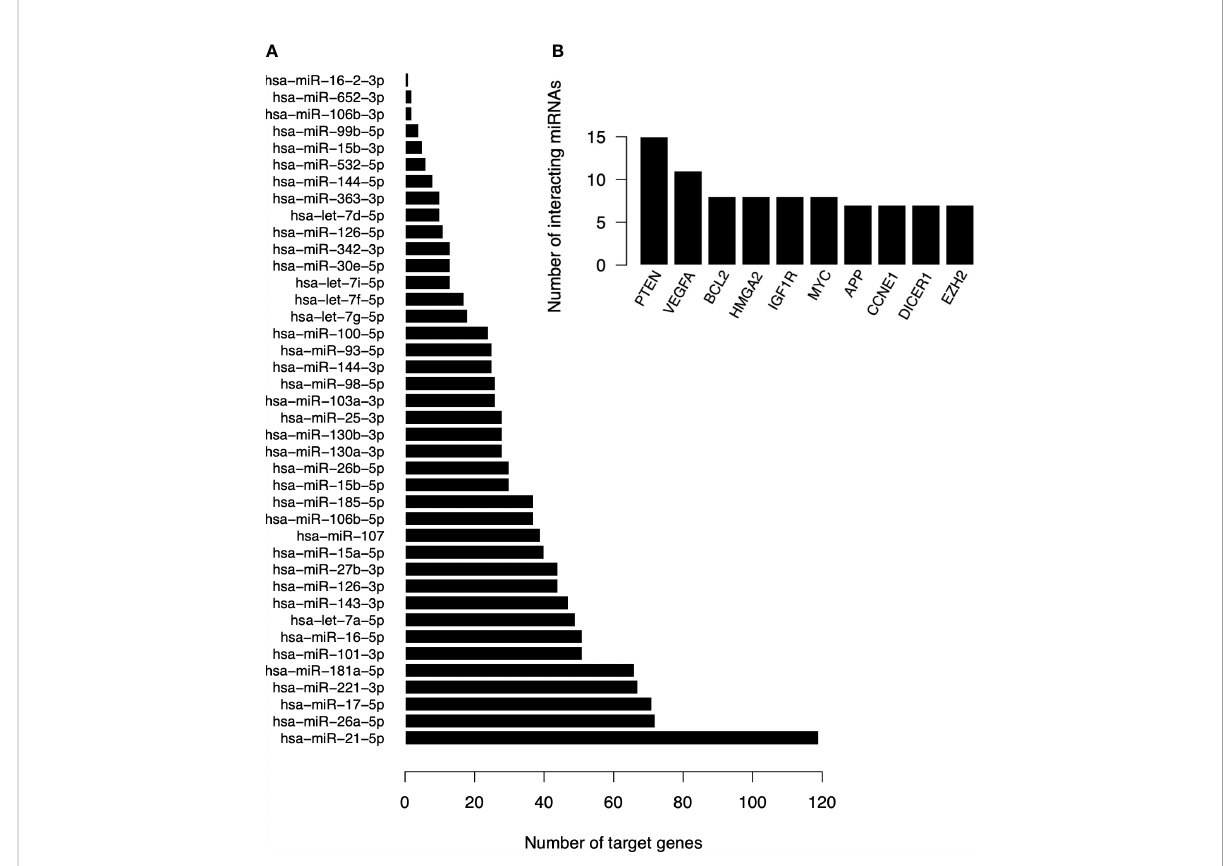
FIGURE 4 Quantitative of target genes of DE miRNAs in T1DM. (A) Number of target genes per DE miRNA. (B) Number of interacting miRNAs for the ten most frequently found